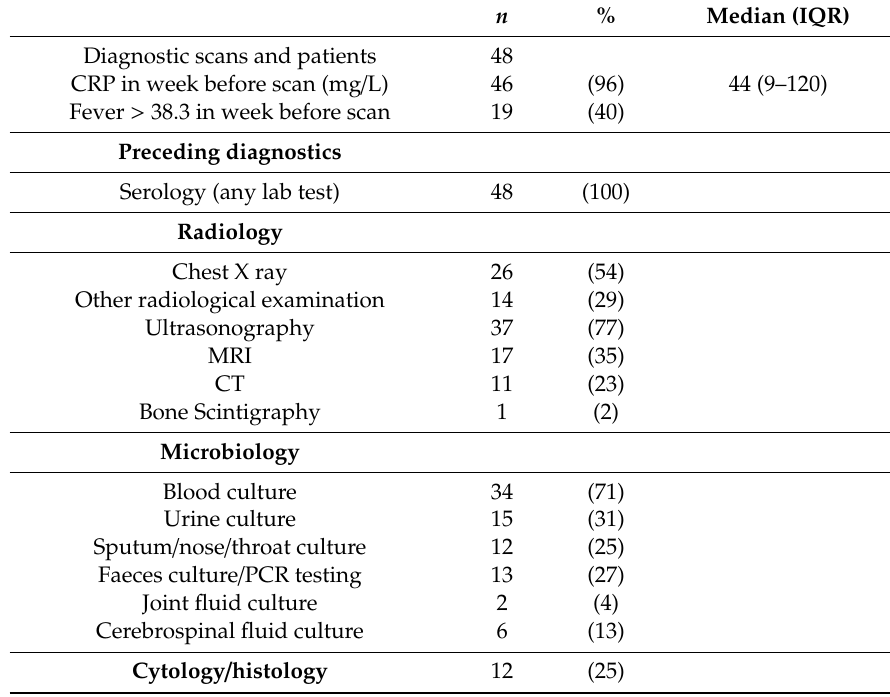
Table 2. Characteristics of patients with diagnostic